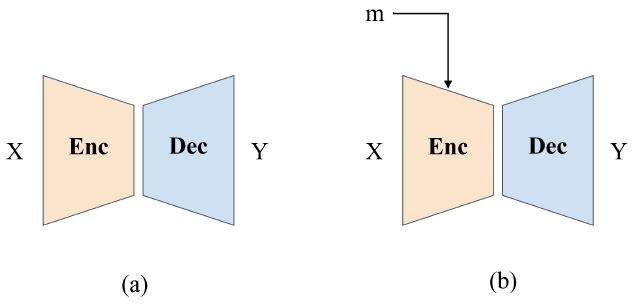
Figure 1. The paradigm of the semantic segmentation pipeline. Most works adopt an encoder–decoder structure such as ( a ), where X is the input image and Y is the predicted segmentation mask. In ( b ), the model learns to predict the segmentation mask based on both the input image and the memory m. Memory is used to help encode some contextual information of the dataset and is learned along with the model parameters. Skip connections between the encoder and decoder are omitted in the figure for